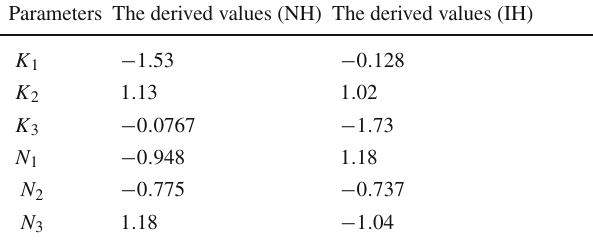
Table 4 The model parameters in the case sin θ = 0 . 25, and sin α = 0 . 445 for NH and sin θ = 0 . 25 and sin α = 0 . 75 for IH Parameters The derived values (NH) The derived values (IH) K